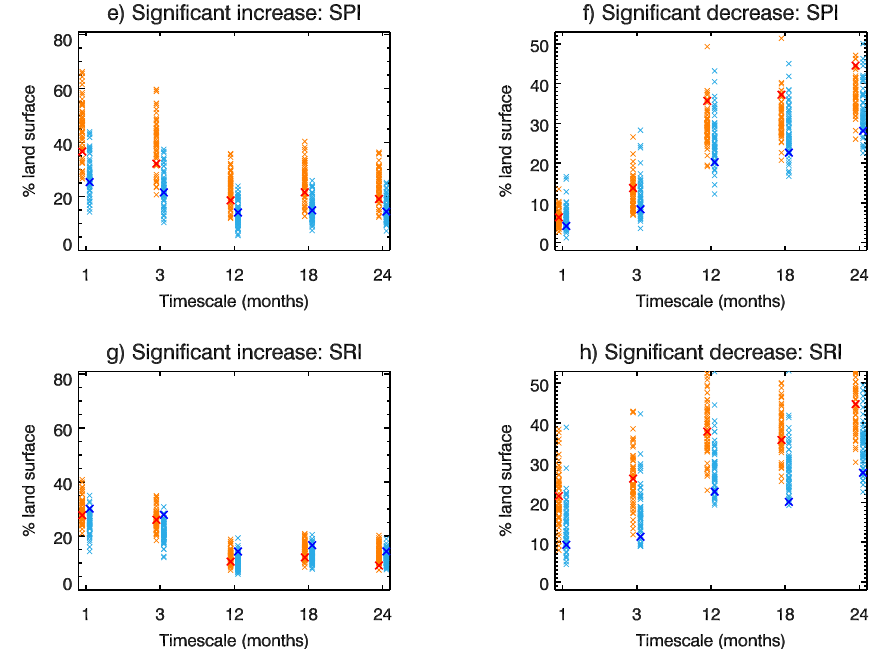
Fig. 8. The percent of the land surface (non-cold areas) with significant changes (as defined in Sect. 3.1) in the time spent in drought in the 2080s (2070–2099) as given by the ESE (increases – left column, and decreases – right column) for the SPI: (a) , (b) ; and SRI: (c) and (d) at the different integration timescales. The A1B future scenario is shown in orange and RCP2.6 shown in blue. The crosses represent individual model responses with the exemplar ensemble member marked larger symbols in red (A1B) and dark blue